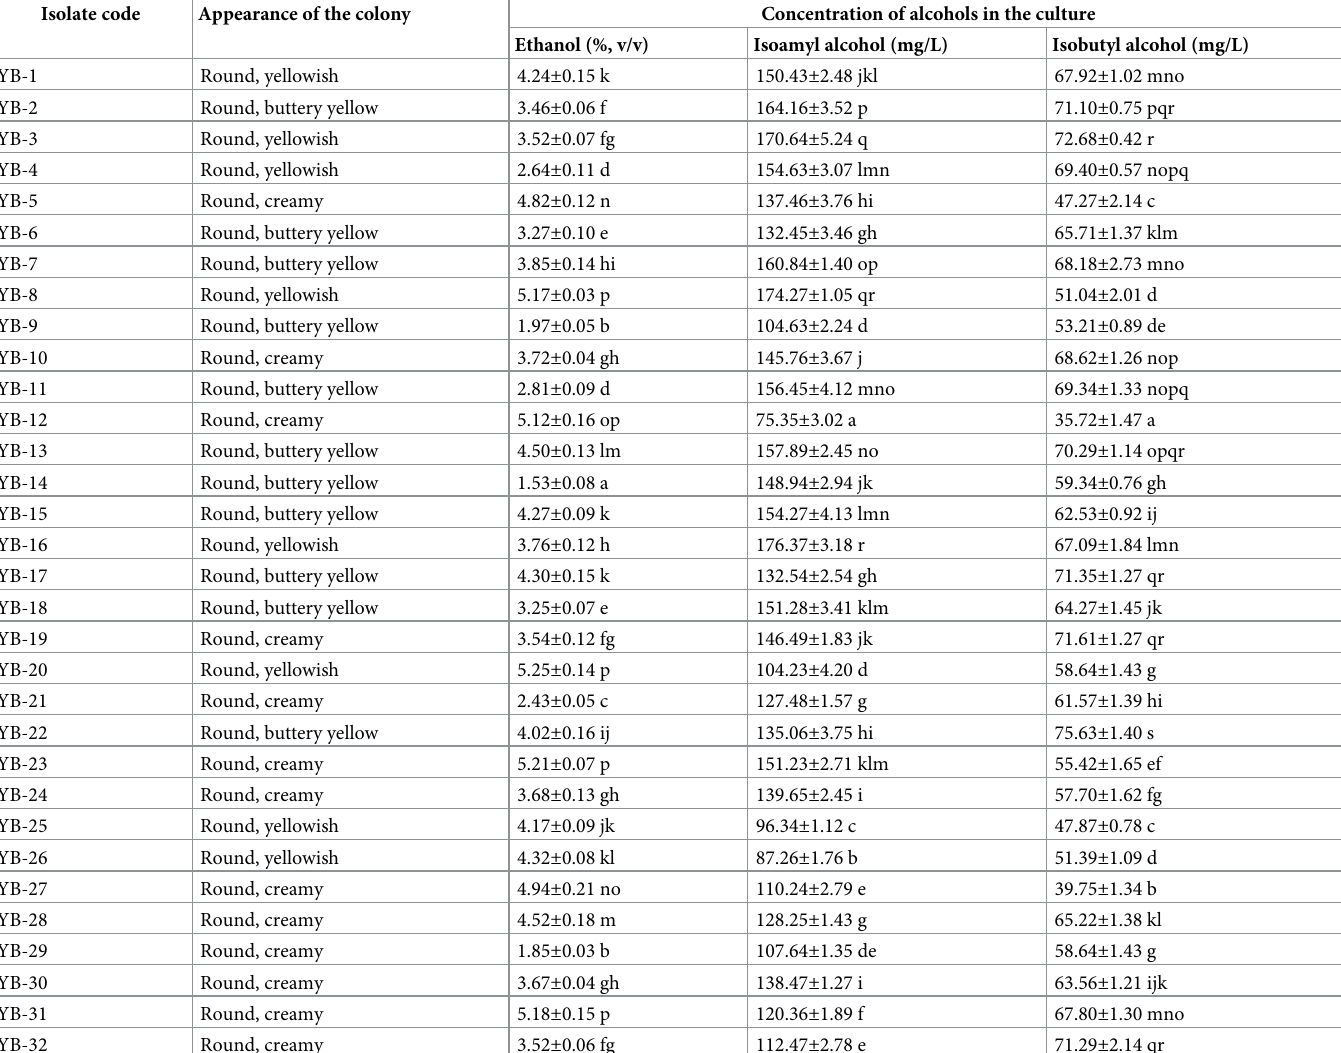
Table 2. Screening results for yeast